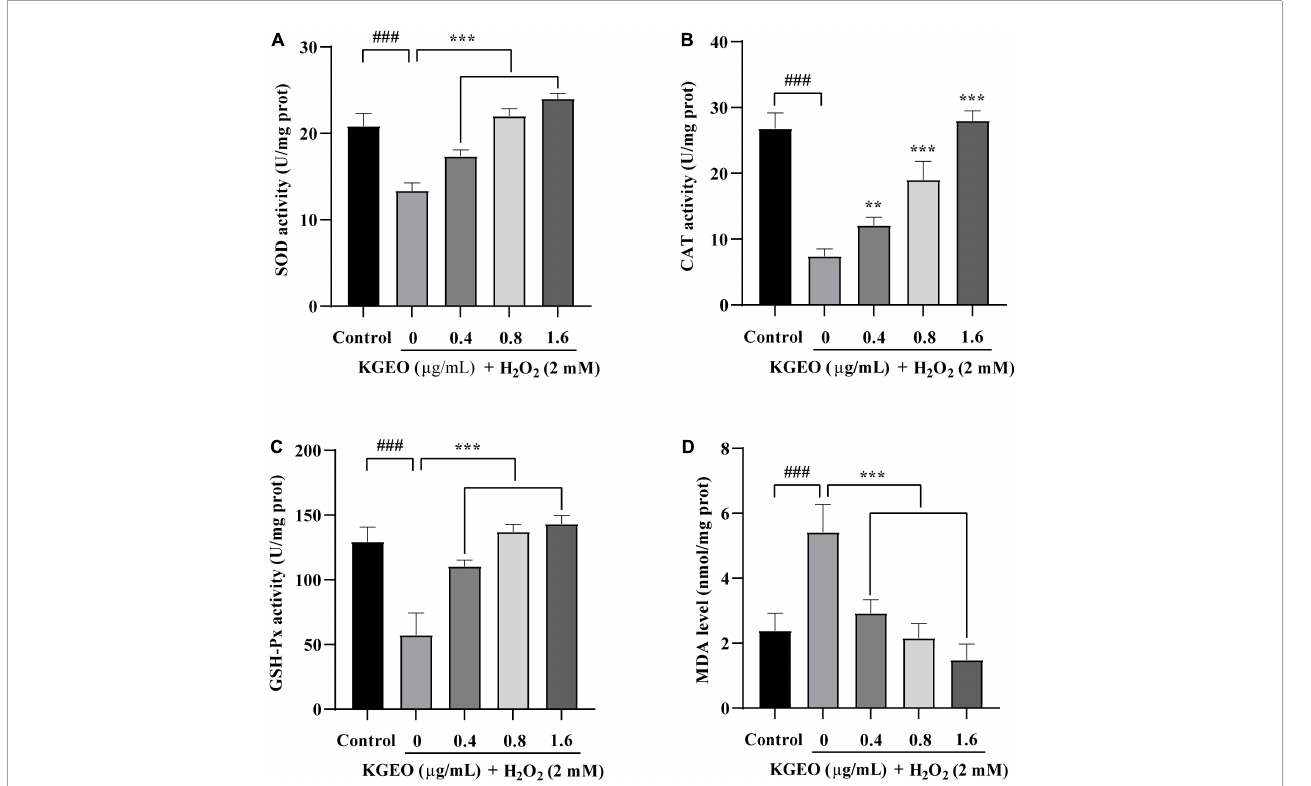
FIGURE3 The effects of Kaempferia galanga essential oil (KGEO) on levels of malondialdehyde (MDA) and antioxidant enzymes activity in H 2 O 2 -induced zebrafish. Superoxide dismutase (SOD) activity (A) , catalase (CAT) activity (B) , GSH-Px activity (C) , and MDA level (D) were determined after incubation. The data are expressed as mean ± SD ( n = 15). ### P < 0.001 as compared to the control group. ** P < 0.01, *** P < 0.001 as compared to the H 2 O 2 -treated